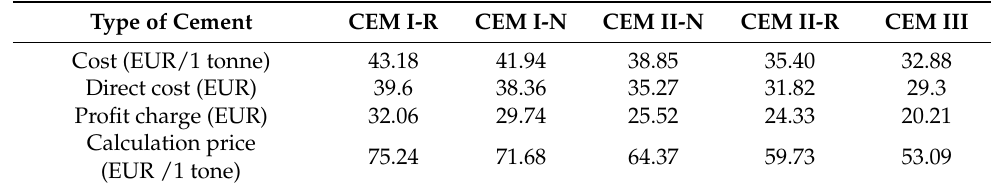
Table 4. Data for economic analysis of product—cement. Type of